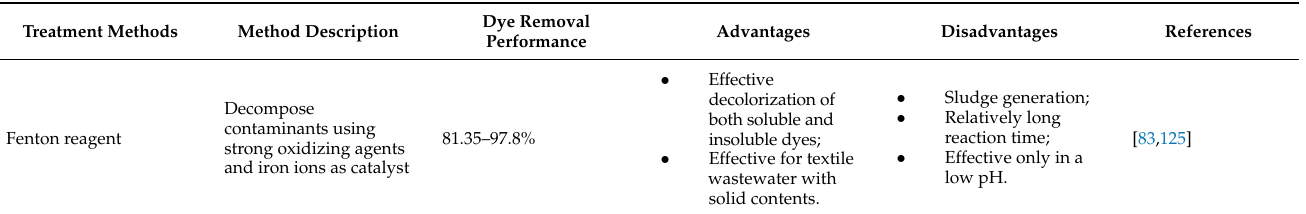
Table 6. Advantages and disadvantages of main physical, chemical, and biological methods of dye removal in textile wastewater (summarized from